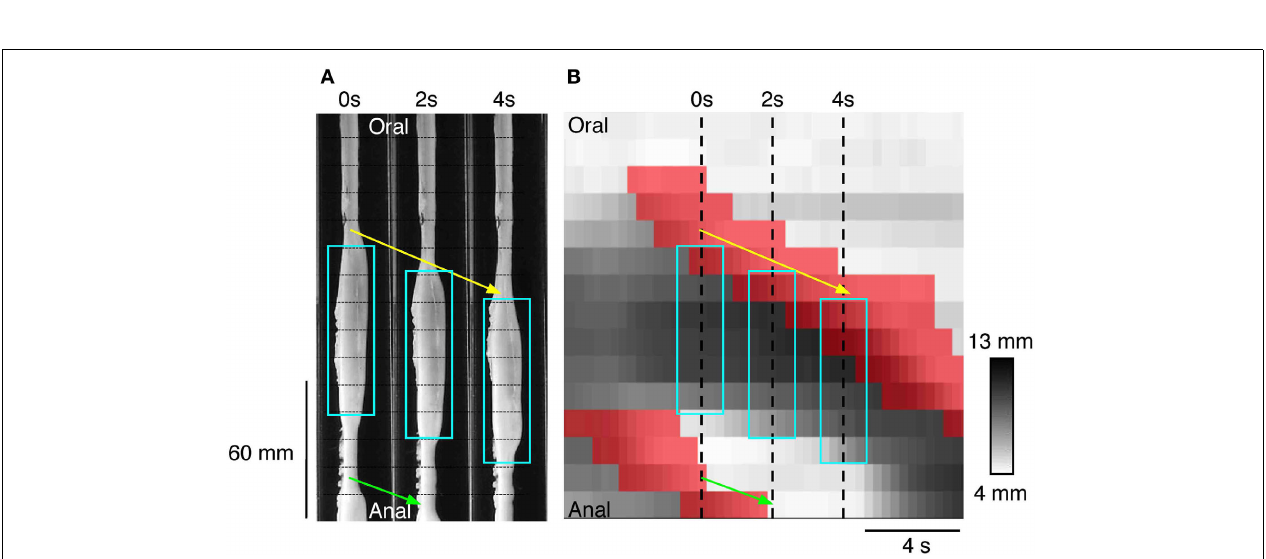
these maps all active propagating and non-propagating contractions were identified. The black hatched box on R2 indicates the region from which Figures 8 , 11 were made.